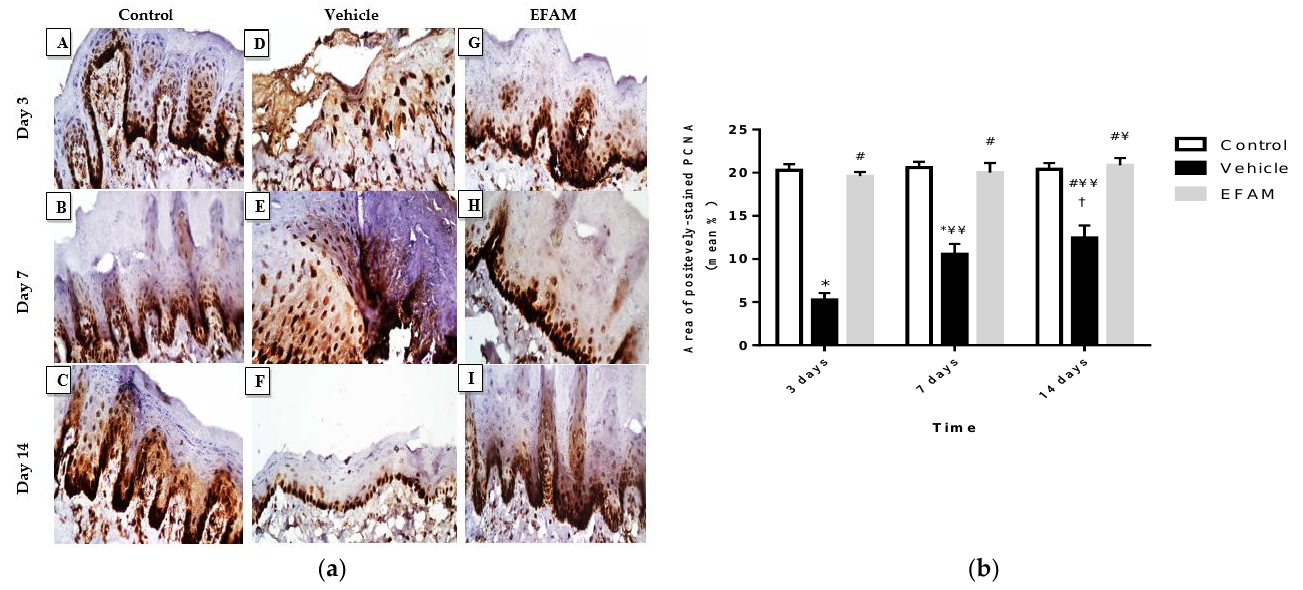
Figure 6. ( a ) Immunohistochemical staining of the positively-stained PCNA in the tongue ulcer (magnification, × 400, the scale bar indicates 50 µ ). ( A – C ): Normal rats were treated with the vehicle only on days 3, 7, and 14, respectively. ( D – F ): Acetic acid-induced tongue ulcer rats treated with vehicle only on days 3, 7, and 14, respectively. ( G – I ): Acetic acid-induced tongue ulcer rats treated with EFAM on days 3, 7, and 14, respectively. The brown precipitate represents positively-stained PCNA. ( b ) Amount of positively immunostained PCNA, expressed as the mean area percentage (mean%), in the control, vehicle, and EFAM groups on 3, 7, and 14 days. * p < 0.0001 vs. control group of the same time interval, and # p < 0.0001 vs. vehicle group at the same time interval, ¥ p < 0.05, ¥¥ p < 0.0001 vs. respective group on day 3 and † p < 0.05 vs. respective group on day 7 using two-way ANOVA followed by Bonferroni as a post hoc test. Results shown as mean ± SD ( n =